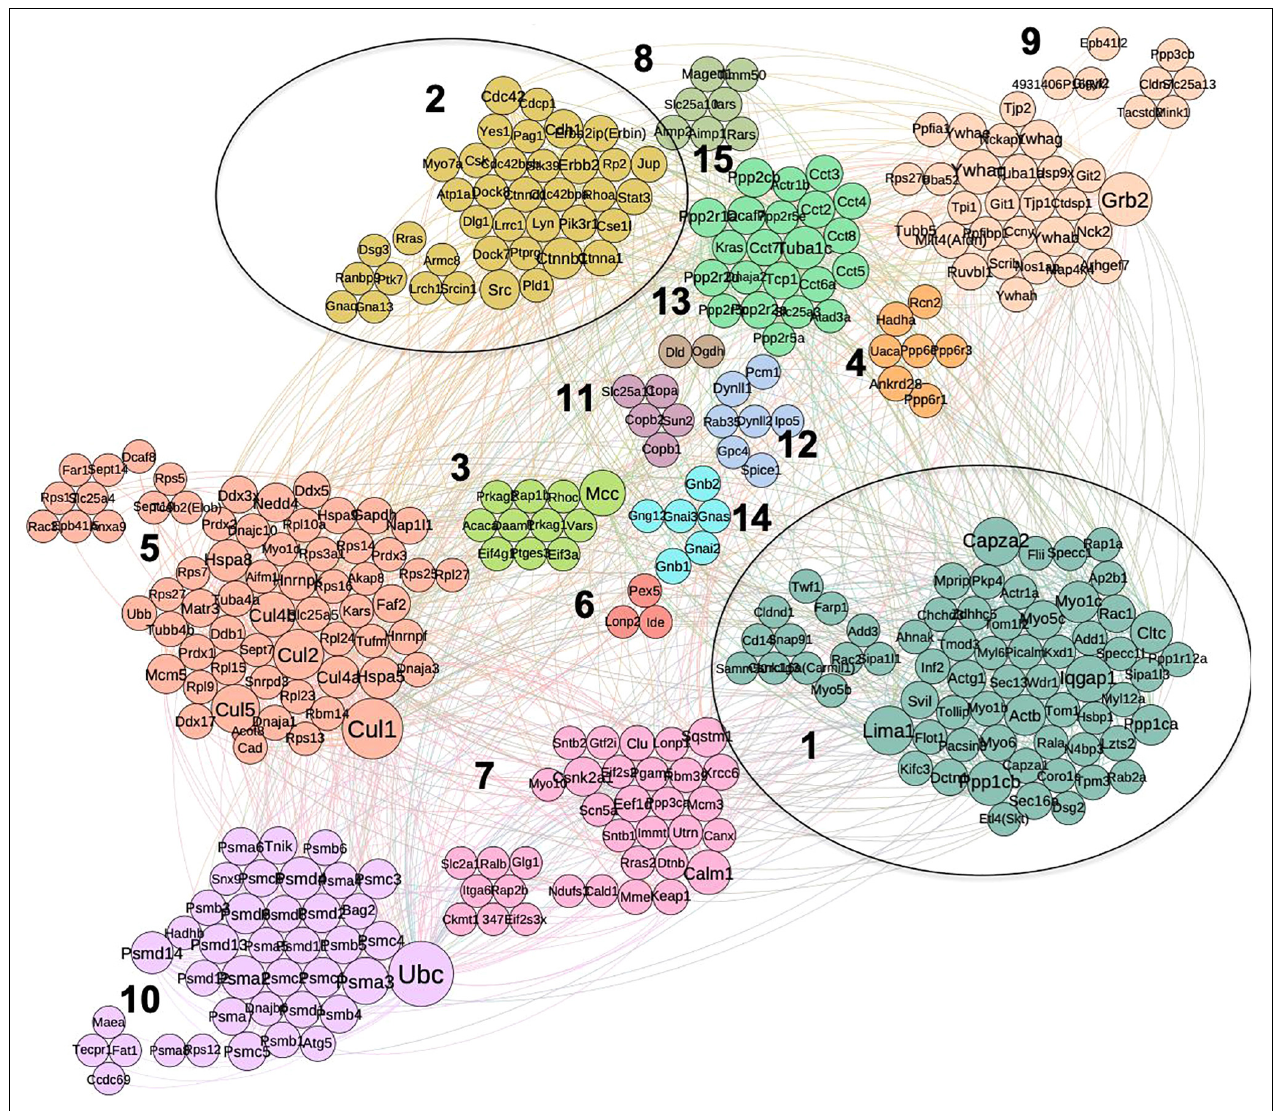
FIGURE 3 | Community structure of p140Cap protein complex in breast cancer obtained by spin-glass algorithm. Fifteen distinct communities are highlighted in different colors; clusters that overlap with synaptic network (1 and 2) are